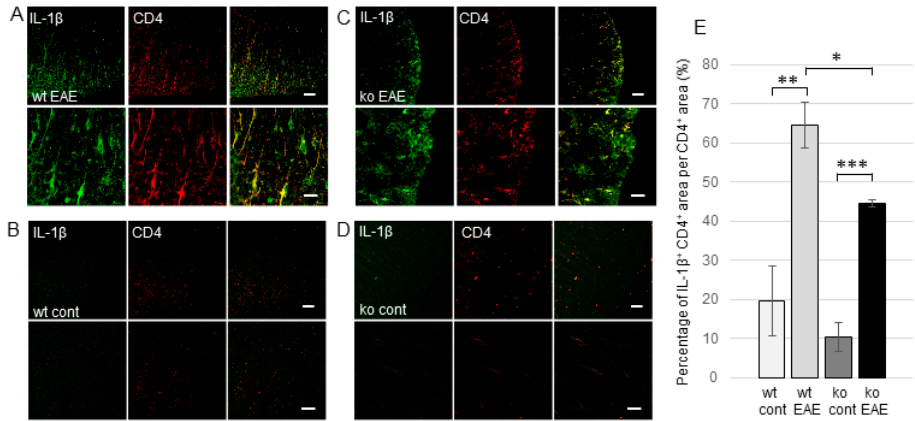
Figure 4. Expression of IL-1 β in CD4 + T cells in the spinal cords of EAE and control mice. Immunohistochemistry image showing IL-1 β (green) and CD4 (red) in the inflammatory region of the spinal cords of wt EAE ( A ), wt control ( B ), ko EAE ( C ), and ko control ( D ) mice. Percentage of the IL-1 β + CD4 + area in the CD4 + area of EAE spinal cords ( E ). Scale bar (50 μ m) for upper panels and (20 μ m) for lower panels of ( A – D ). wt, wild-type; ko, mPGES-1 − / − ; cont, naïve mice; EAE, EAE mice. * p < 0.05, ** p < 0.005, *** p < 0.0005.